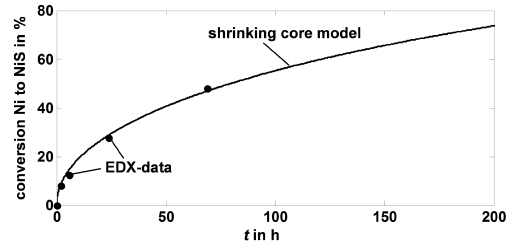
Figure 6. Amount of NiS plotted against the sulfidation time = 500ppm). The line is calculated with the ( T = 300 ◦ C; c H 2 S shrinking core model (Eq. 5). Dots are determined by EDX.